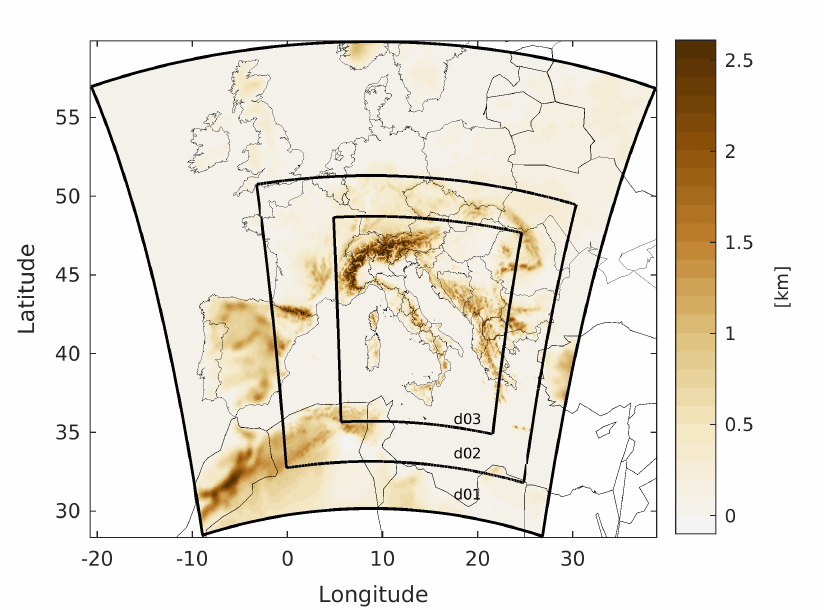
Figure 3. The three domains setup adopted for Weather Research and Forecasting (WRF) in the current study, showing the model orography in